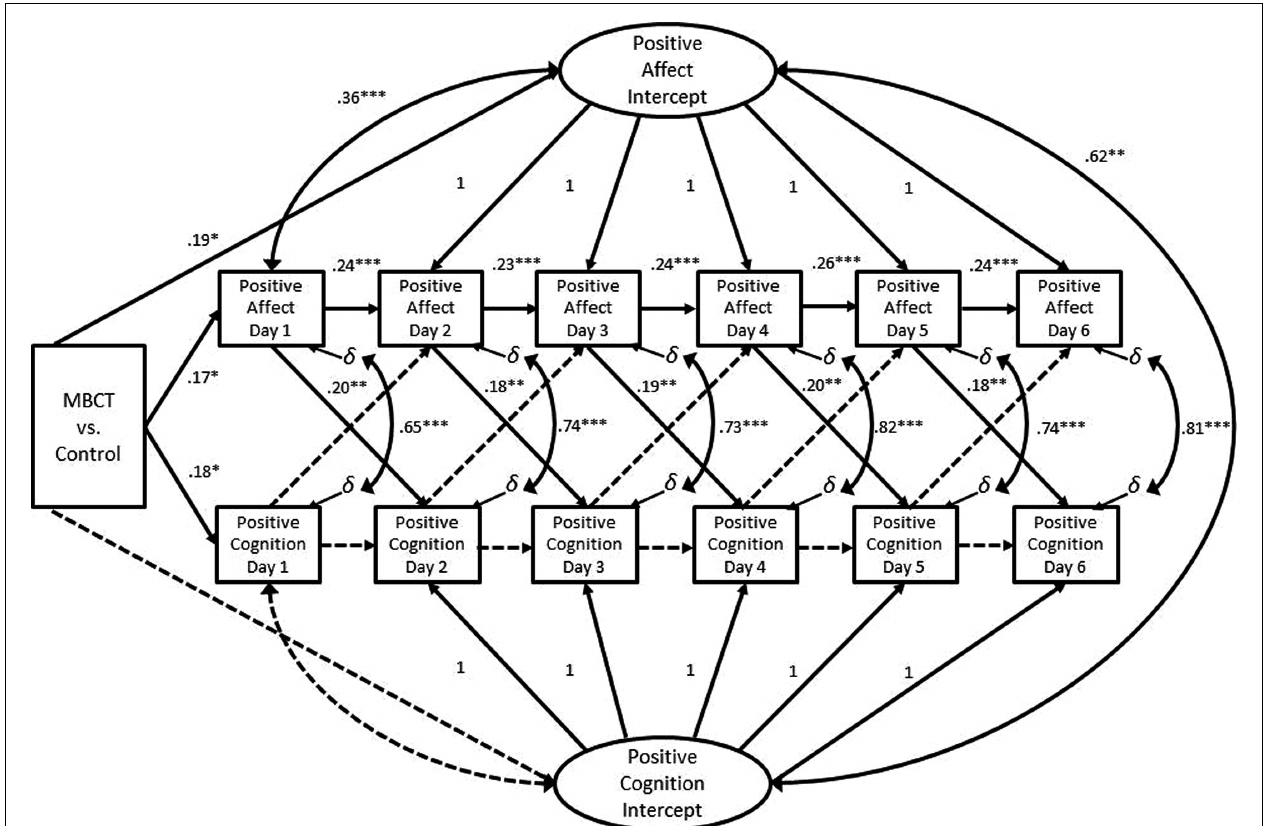
cognition factors were regressed onto average daily level of positive affect and cognition during the 6-day pre-assessment period. Similarly, error terms and non-significant parameter estimates are not shown. Non-significant paths are represented by dashed arrows with no parameter estimates. Correlations are represented by double-headed arrows. Factor loadings are marked with the value of 1; all other parameter estimates are standardized regression weights. * p ≤ 0.05; ** p < 0.01; *** p <